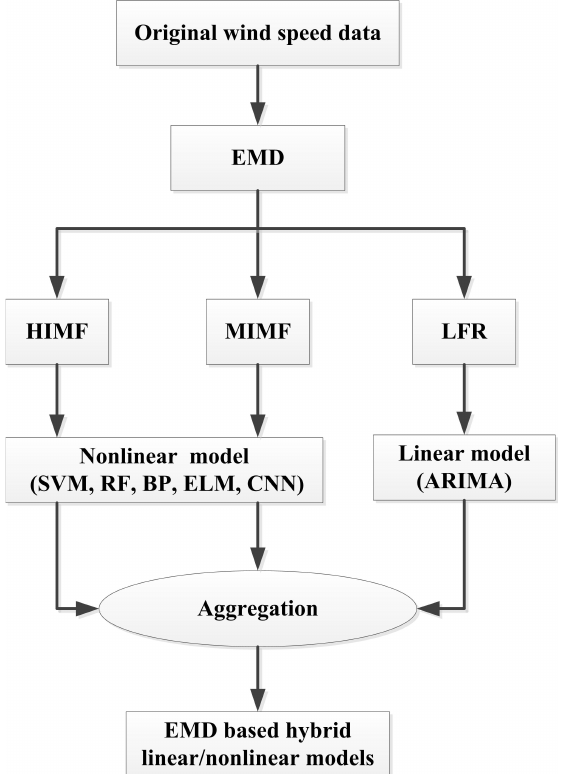
Figure 1. Solution process for the empirical mode decomposition (EMD) based hybrid linear/nonlinear models. Intrinsic mode functions (IMF), high-frequency IMF (HIMF), medium-frequency IMF